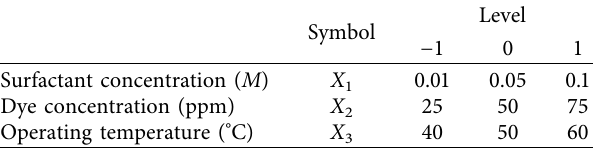
Figure 3: Cloud point of TX-114 with various concentration of RB-5 dye. Table 1: Various levels of experimental